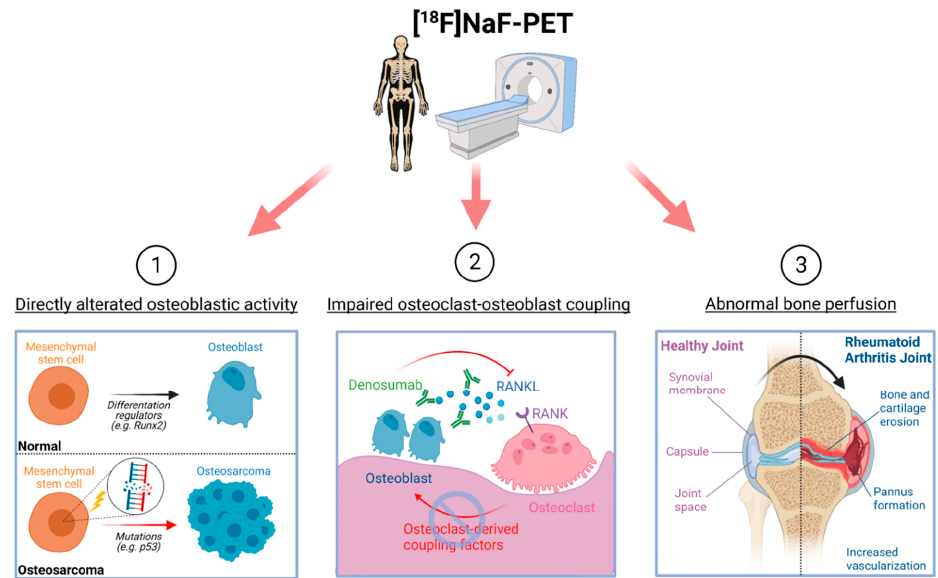
Figure 2. Cellular mechanisms that influence observed 18 F-NaF activity. 18 F-NaF-PET depicts bone turnover by detecting direct alterations in osteoblasts, impaired osteoblast–osteoclast coupling, and abnormal bone perfusion.